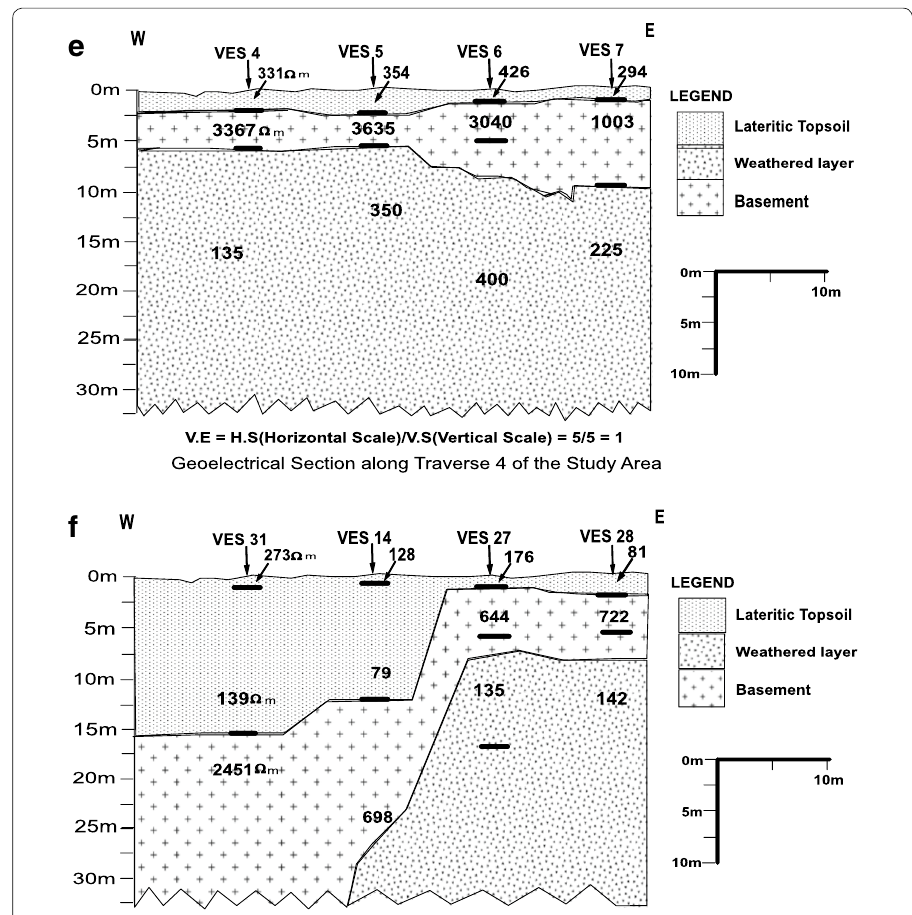
Fig. 8 Geoelectric sections along traverse 4 and